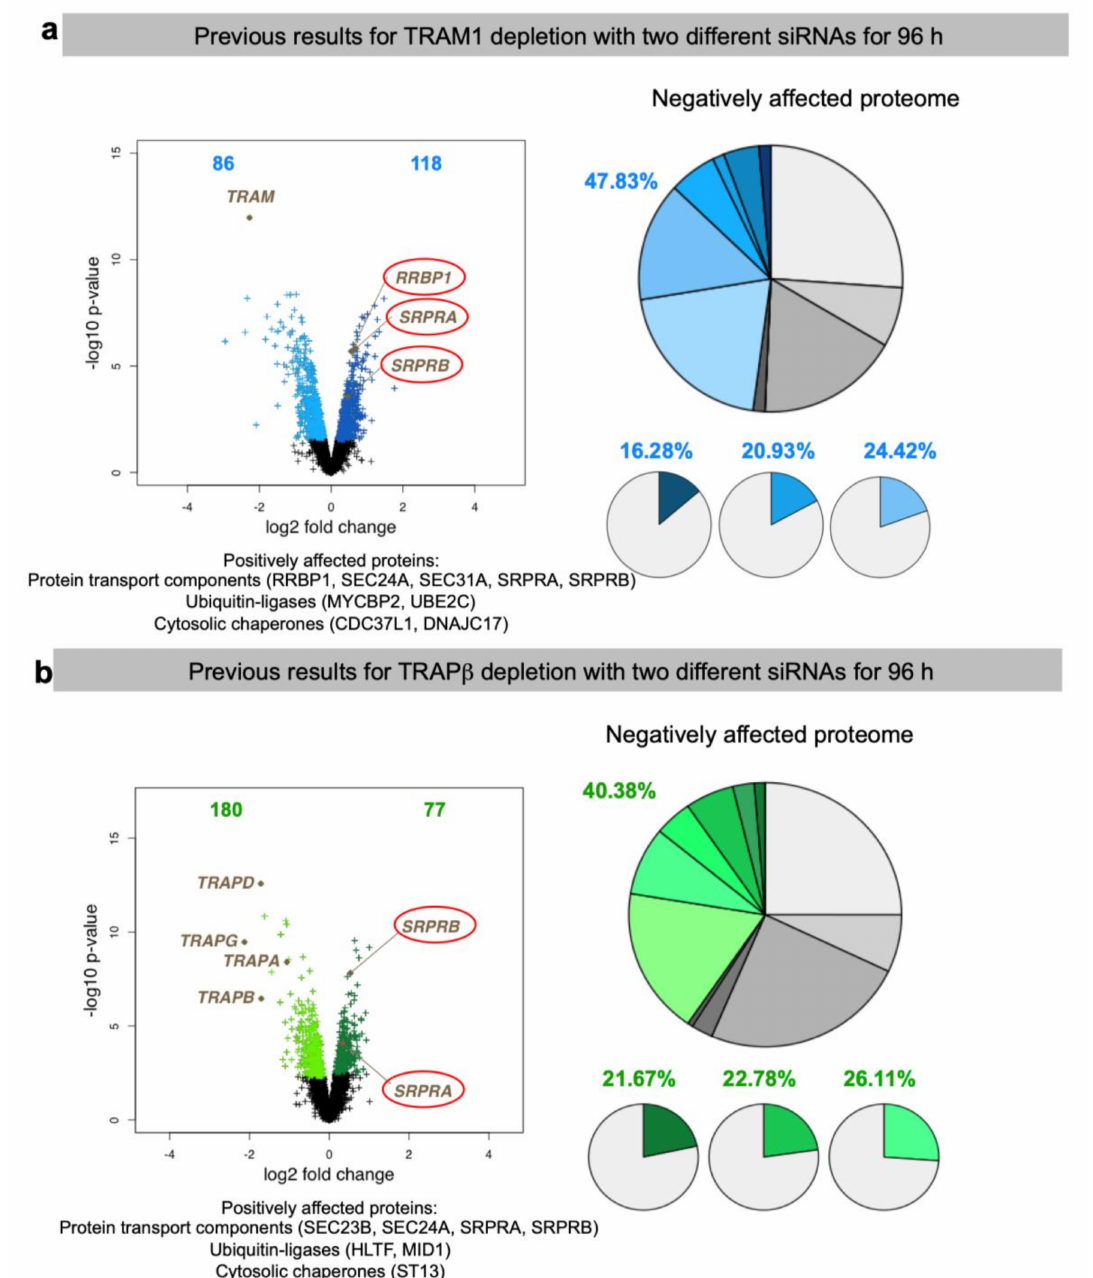
Figure 10. Representative volcano plots and GO enrichment after TRAM1 and TRAP depletion, respectively. Differentially affected proteins were characterized by the mean difference of their intensities plotted against the respective permutation false discovery rate-adjusted p -values in volcano plots. The representative results for a single targeting siRNA are shown on the left. TRAM1 ( a ) and TRAPB ( b ), which is synonymous to SSR2 and codes for TRAPß, RRBP1 and subunits of the SRP receptor are highlighted in the plots. In addition, the numbers of proteins, which were negatively or positively affected in both experiments, are given; the full set of relevant positively affected proteins are given below. Classification of the respective clients was based on GO enrichment factors where the results from the complete set of quantified proteins (not shown) are compared with the negatively affected proteome. Protein annotations of signal peptides, membrane location, and N-glycosylation in humans were extracted from UniProtKB, and used to determine the enrichment of GO annotations among the negatively affected proteins. The figure summarizes results from previous experiments and is shown here in modified form for comparison